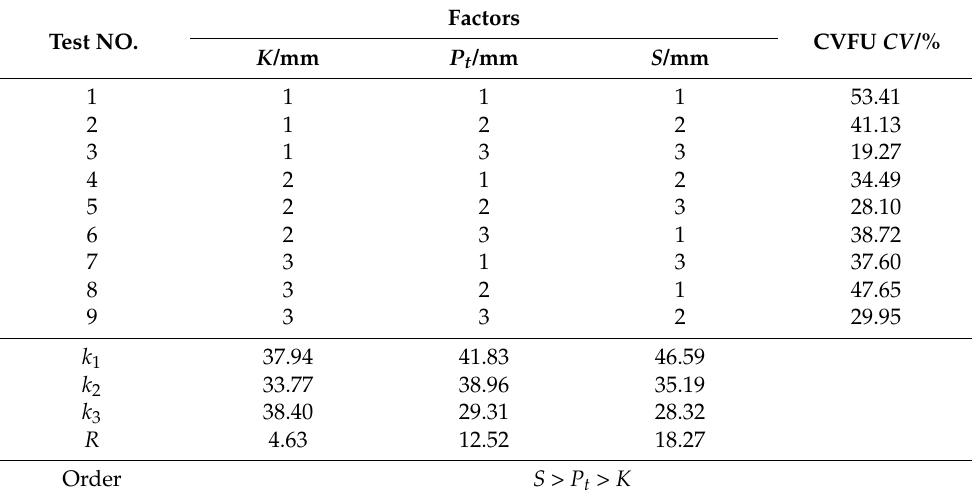
Table 4. Orthogonal test